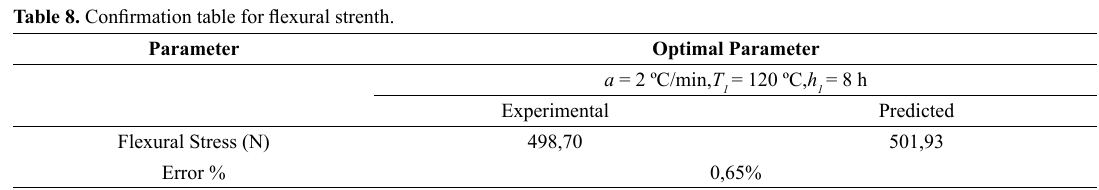
Table 8. Confirmation table for flexural strenth.